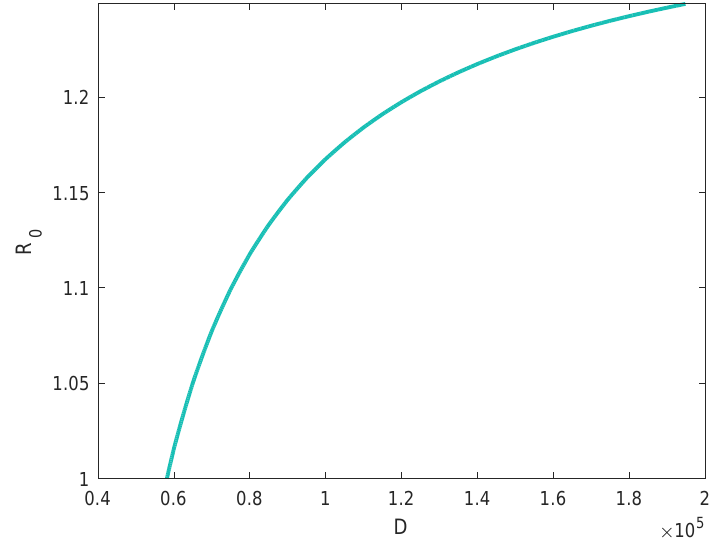
Figure 2. The curve shows the R 0 − D pairs that explain dog population growth between the years 2013 and 2016 in Dhaka city, where R 0 is the basic reproduction number and D is the environmental carrying capacity of